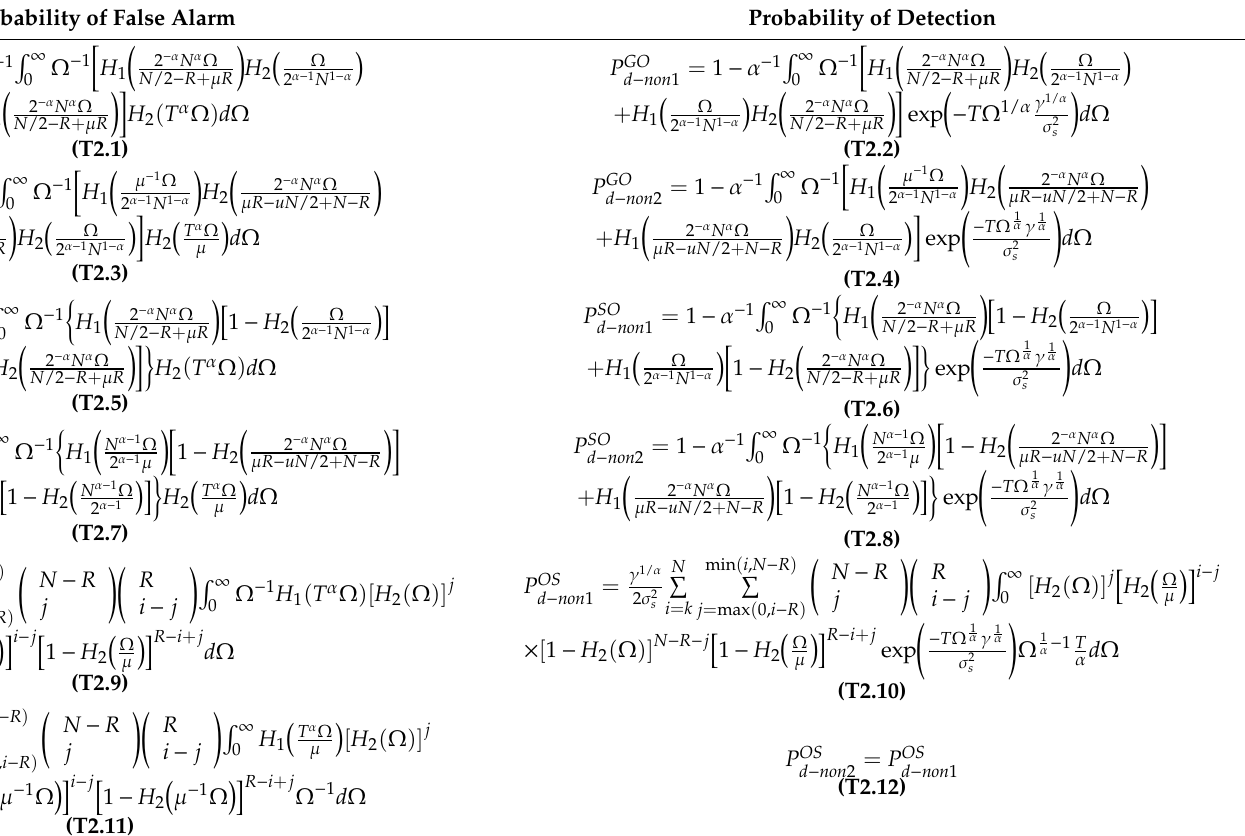
Table 2. The Pfas and Pds of di ff erent detectors in a nonhomogeneous P α S background. Probability of False Alarm Probability of